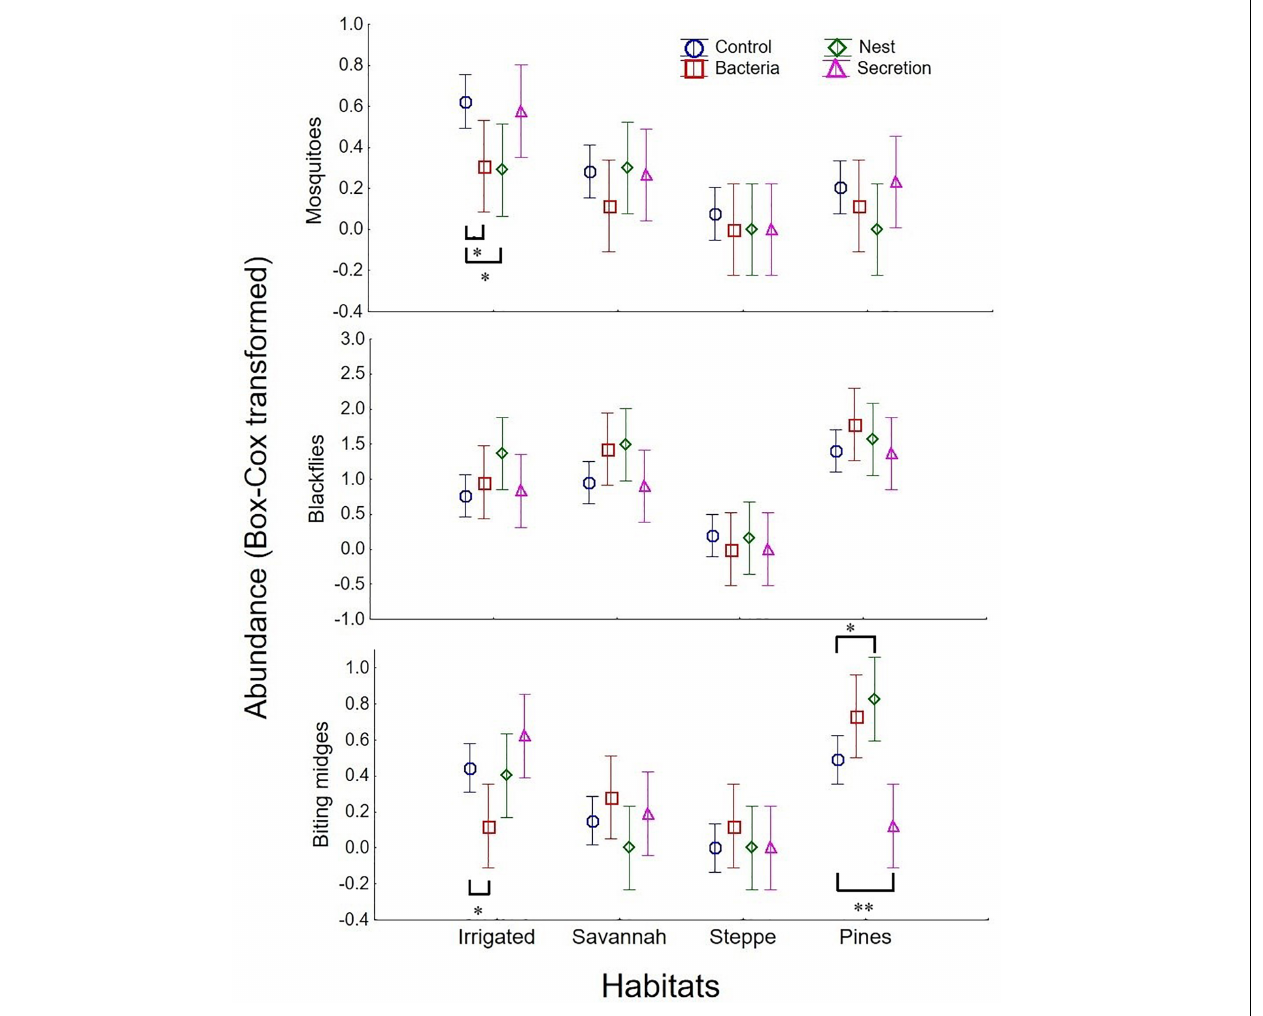
FIGURE 2 | Abundance of blood-feeding flies (mosquitoes, blackflies, and biting midges) collected in traps baited with different chemical stimuli derived from hoopoe nestlings or nests (uropygial secretion , nest material, or bacteria found in the secretion), or without stimulus ( control ), and in four different habitats (irrigated, oak savannah, steppe and pine forest). Mean and 95% confidence intervals (CI) are shown. Statistically significant differences between the different chemical stimuli and the control in each habitat are also shown (* p < 0.05; ** p <